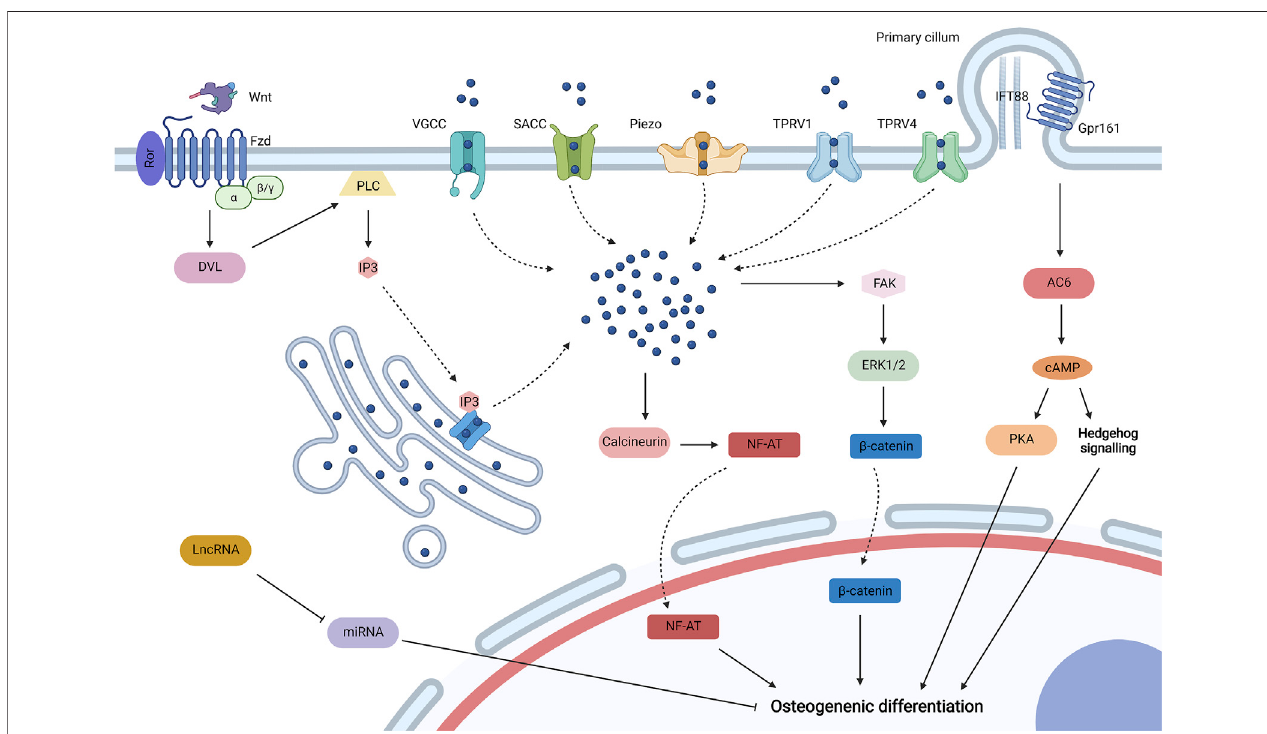
FIGURE 4 | Cell – matrix biophysical transduction for MSC osteogenesis, including integrin signaling and focal adhesion. Integrins generally induce cell adhesion, and integrin signaling may be activated for the osteogenic differentiation of MSCs under biophysical stimuli. Integrin activates phosphatidylinositol 3-kinase (PI3K) to initiate Akt, which then avoids the degradation of β -catenin by inhibiting glycogen synthase kinase-3 β (GSK-3 β ). GSK-3 β can be also impeded by integrin linked kinase (ILK) initiated by integrin. Activated ILK can also promote the cytoplastic accumulation of β -catenin by dissociating β -catenin from cadherin. β -catenin is then translocated to the nucleus for osteogenic differentiation. Integrin can also initiate FAK to activate mitogen-activated protein kinase (MAPK) (such as ERK1/2) to phosphorylate transcription factors, such as Runt-related transcription factor 2 (Runx2) and nuclear factor κ B (NF- κ B), which then shuttles to the nucleus for MSC osteogenesis.Biophysicalstimulicanbedirectlytransducedbythestructureoffocaladhesion-cytoskeleton-nucleustopromotechromatinforgeneexpression,whichis composed ofintegrin,dockingproteins (DPs), recruited FAK,F-actin,myosin II,stress fi ber,theLinkerofNucleoskeletonand Cytoskeleton(LINC) complex(nesprin and SUN protein), and formin homology 1/formin homology 2 domain containing protein 1 (FHOD1). The structure is mainly regulated by ras homolog family member A (RhoA)signaling.RhoAcanbeactivatedbyleukemia-associatedRhoguaninenucleotideexchangefactor(LARG),whichisinitiatedbytherecruitmentofFynandFAKto initiatemammaliantarget ofrapamycincomplex2(mTORC2).RhoA can bealso activated by initiated Dvl bythebindingofWnttothe Ror/Fzd complex.Activated RhoA initiates LIM kinase (LIMK) by stimulating Rho-associated protein kinase (ROCK), which could inhibit co fi lin to avoid F-actin severing. Activated RhoA also promotes the formation and contraction of the structure by initiating Diaphanous (Dia). Furthermore, contracted cytoskeleton may diminish the mechanical resistance for the translocation of Yes-associated protein (YAP) and transcriptional co-activator with PDZ-binding motif (TAZ) to the nucleus for osteogenesis. Created with